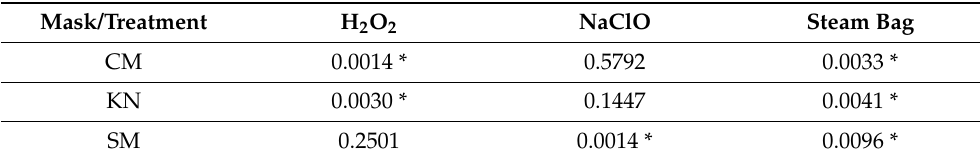
Figure 5. Experimental results obtained for the air permeability, stratified according to the type of mask (CM, KN, SM) and decontamination treatment (H 2 O 2 , NaClO, Steam Bag). Each bar corresponds to the mean of all measurements obtained for each level of cycles (6 replicates); the error bars depict the standard error of the mean. Table 2. One-way analysis of air permeability (non-parametric, two-tailed Kruskal–Wallis using ranks). This statistical test was conducted for each combination of RPD (CM, KN, SM) and decon- tamination treatment (H 2 O 2 , NaClO, Steam Bag), in a total of 9 distinct cases. The table presents the p-value obtained in each such case, where the results obtained across different cycles are compared (control, 5c, 10c); the conditions across the table entries follow the same pattern as in Figure 5. The software used was JMP ® PRO ver. 15.0, from SAS Institute Inc.). Statistically significant differences (significance level of 5%) are signalled with an asterisk